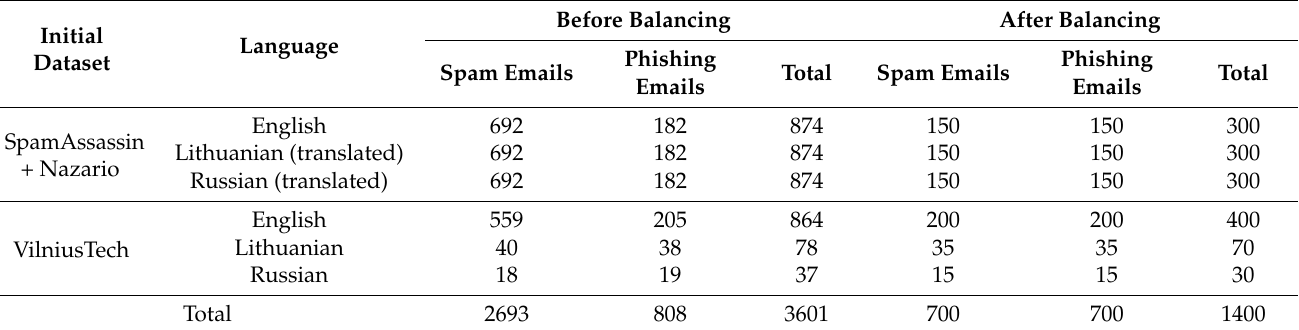
Table 2. Summary of prepared spam and phishing dataset.